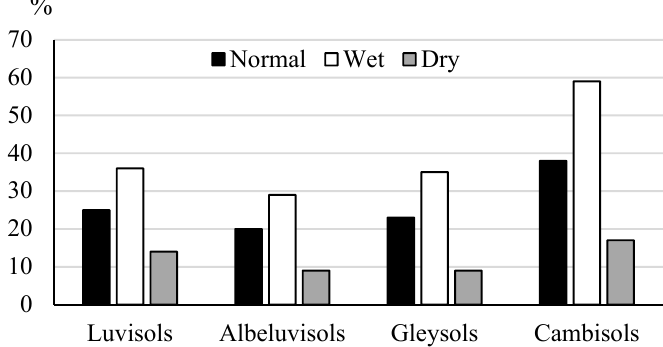
Figure 3. The measured drainage runoff volume in % of annual precipitation amount in different years (estimated and adopted from 1995–1997 data obtained in V ė žai č iai drainage plot site and from 1995–1999 in Akademija site).